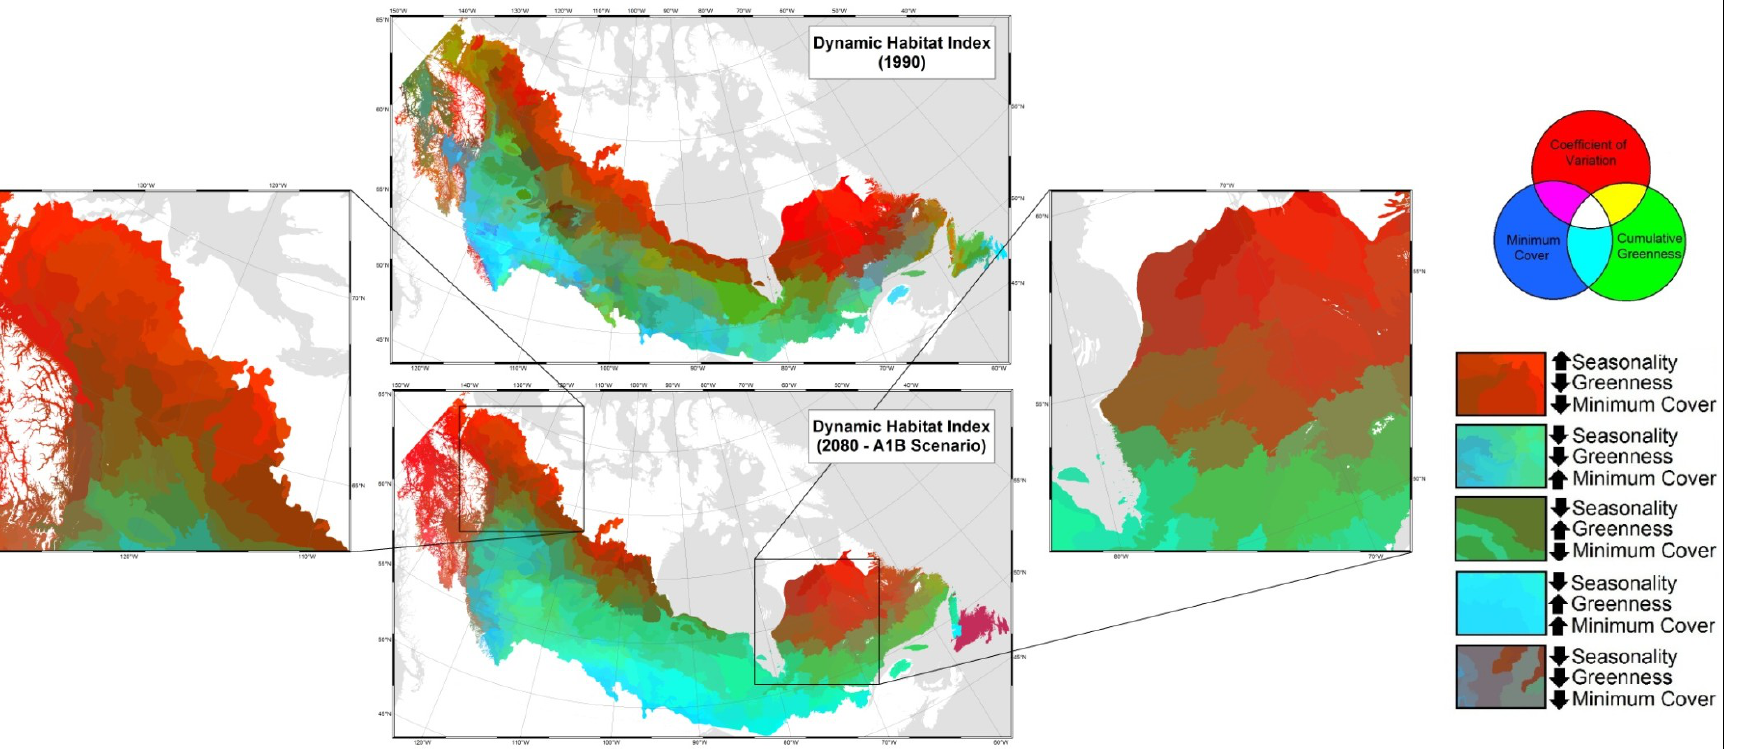
Figure 6. Composite DHI model results for observed 1990 and 2080 (A1B). Maps are a simultaneous display of the three DHI components where the red, green, and blue color bands represent seasonality, cumulative greenness, and minimum cover, respectively. Dark colored regions have low values in all DHI components while light colored areas have high values. Areas of definitive color indicate a dominant habitat indicator; for example a region that is purely red denotes high seasonal variation in greenness. As indicators shift in 2080, such as when seasonal variation in greenness decreases, other components such as annual cumulative greenness or minimum annual cover fill into newly favorable habitats. Common DHI blending occurred with light blue, yellow, and darker colorations like purple or dark orange. The light blue regions represent the most productive habitats with high minimum annual cover, high annual cumulative greenness, and low seasonal variation in greenness. Darker purple and orange colorations indicate low annual cumulative greenness, low seasonal variation in greenness, and low minimum annual